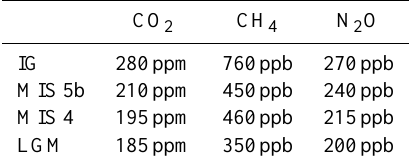
Table 1. Concentrations of long-lived greenhouse gases in the dif- ferent simulations. All instances are given per